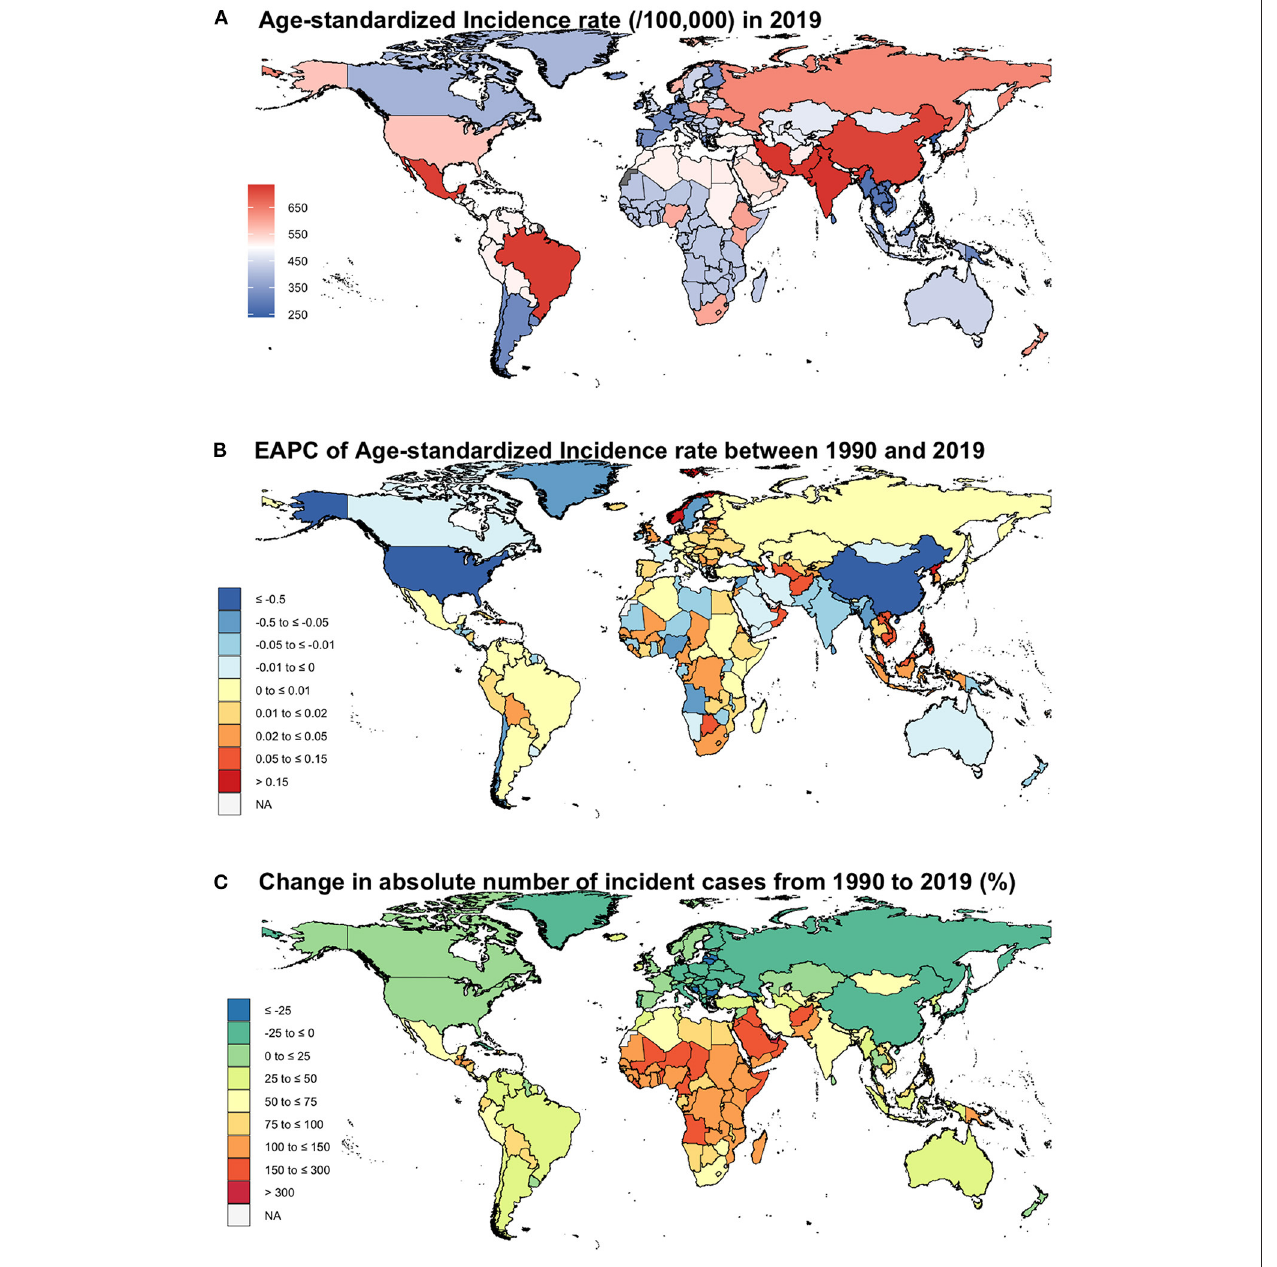
FIGURE 2 | Choropleth maps showing geographic variation in ASIR of IOFBs. (A) ASIR per 100,000 persons in 2019; (B) EAPC of ASIR between 1990 and 2019; (C) Change in absolute number of incident cases from 1990 to 2019 (%). ASIR, age-standardized incidence rate; IOFBs, intraocular foreign bodies; EAPC, estimated annual percent